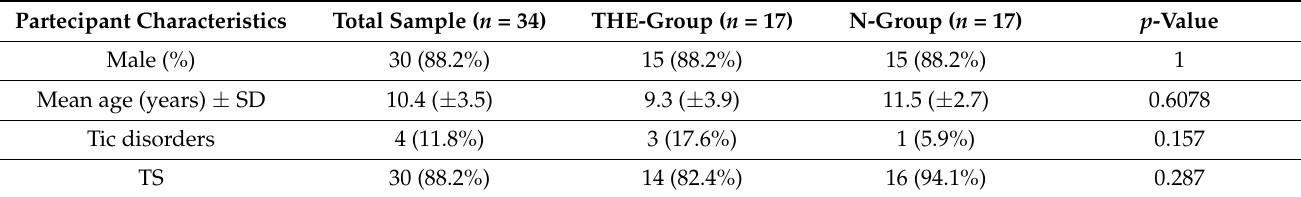
Table 1. Demographic and clinical features of the participants.